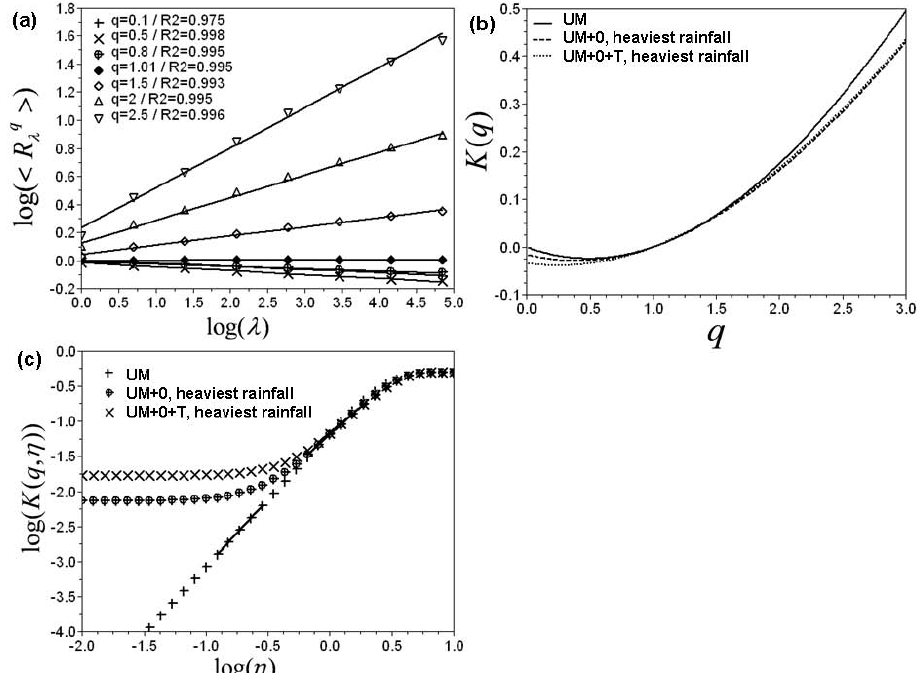
Fig. 5. Considering only the heaviest rainfall: (a) scaling of R λ , (b) K(q) and (c) determination curve of C 1 and α , for simulation parameters C 1 = 0 . 1, α = 1 . 9, γ 0 = 0 . 1 and p 0 = 0 .